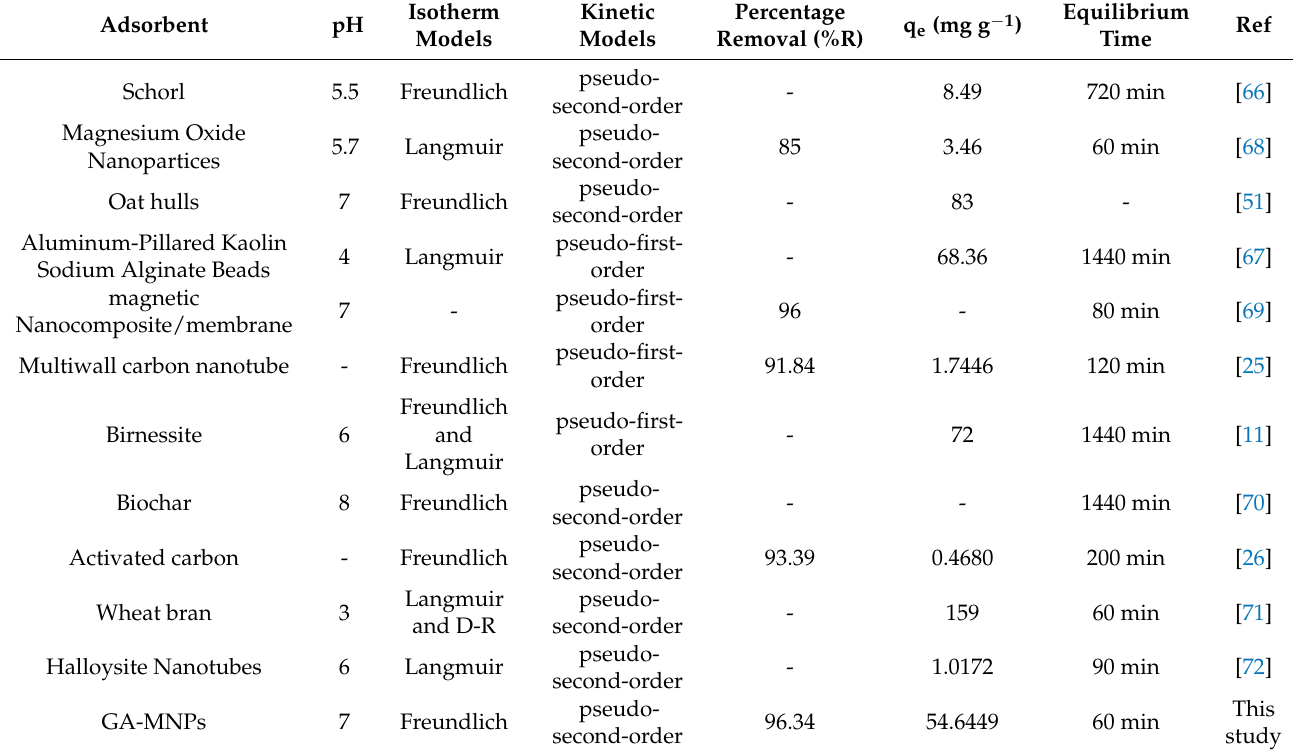
Table 10. Comparison of reported adsorbents with GA-MNP used for CIP